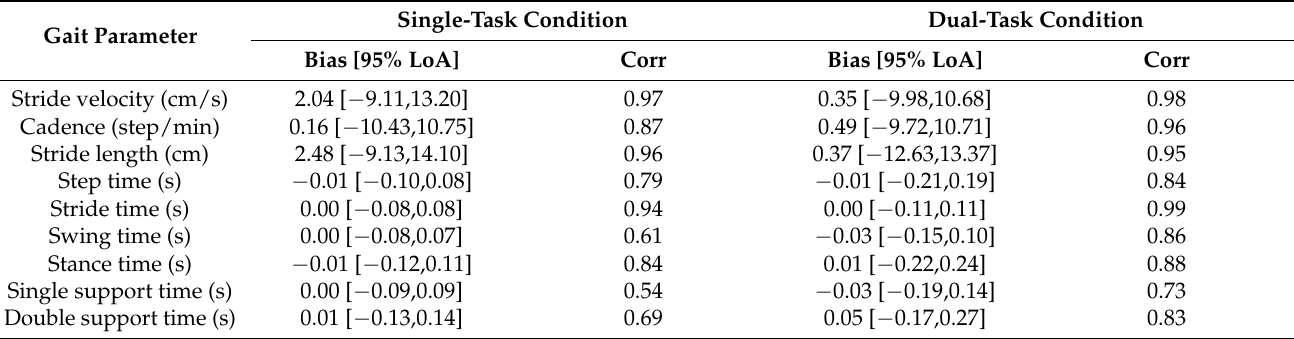
Table 5. Concurrent validity of pressure-sensing insoles and reference electronic walkway during single-task and dual-task condition in the stride-to-stride data